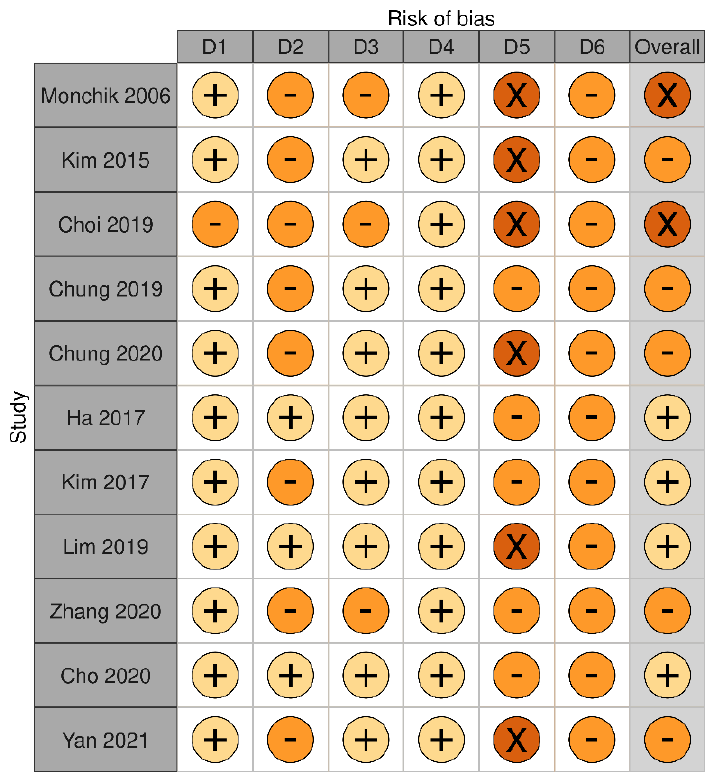
Figure 3. Bias assessment of studies on RFA long-term outcomes in patients with malignant thyroid